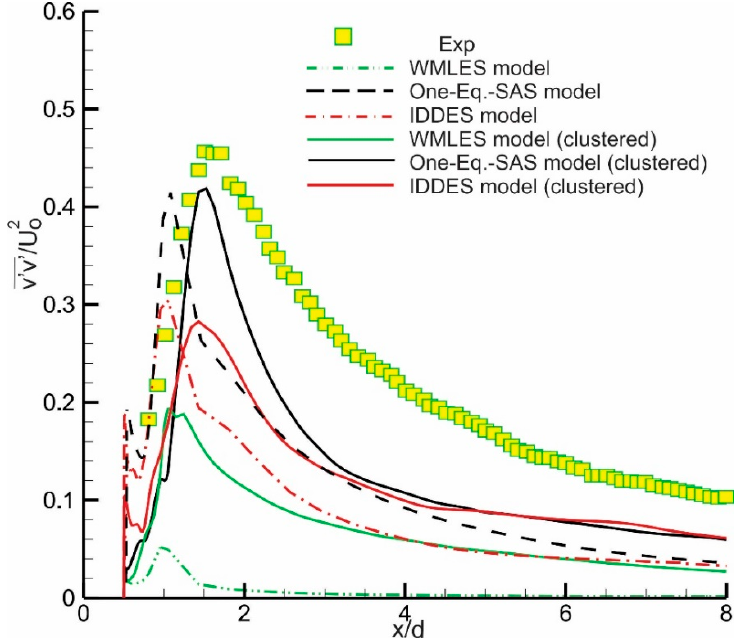
′ ′ 2 on the centerline behind the cylinder in v v /U on the centerline behind the cylinder b b